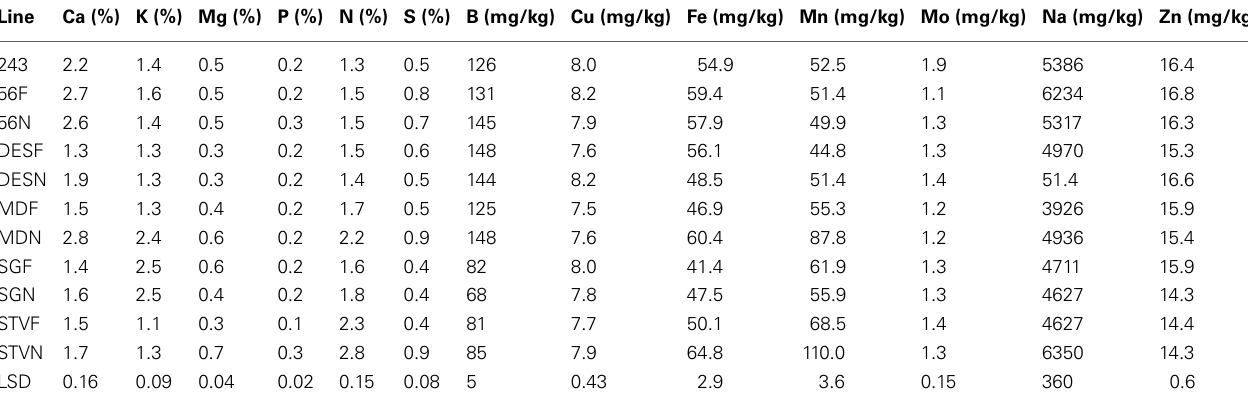
Table 8 | Characterization of leaf mineral composition as influenced by fuzz (F) and fuzzless (N) seed trait in cotton isogenic mutant lines under water stress conditions ∗